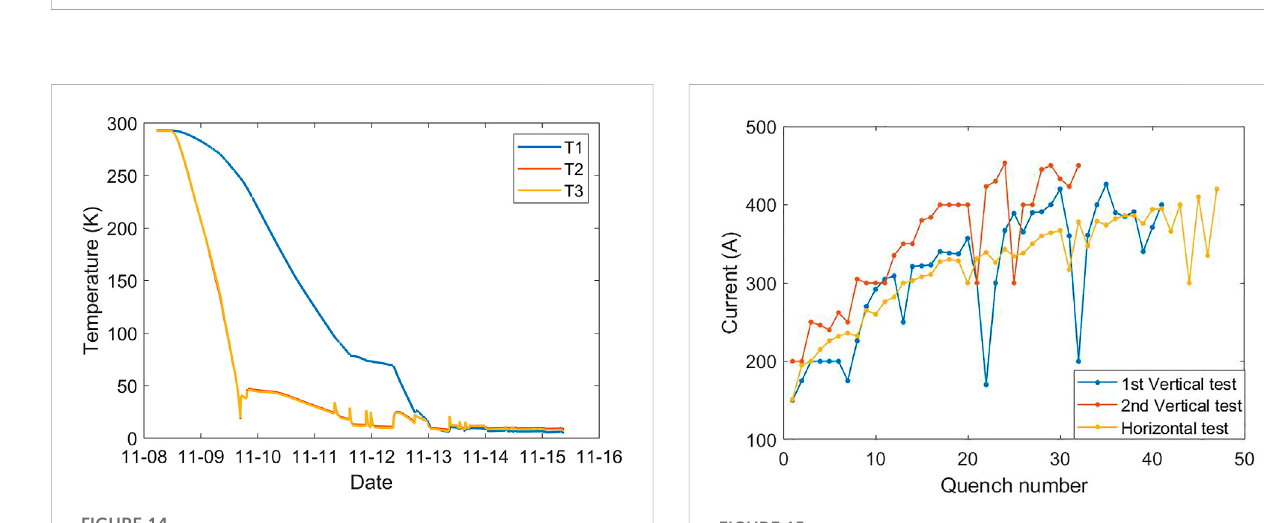
FIGURE 15 Quench currents of the 1.5-m-long SCU during the vertical and the horizontal